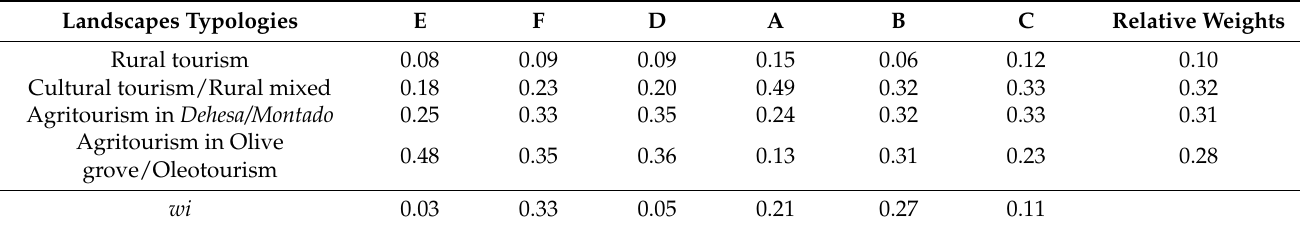
Table 6. Results of the pairwise comparison of the project